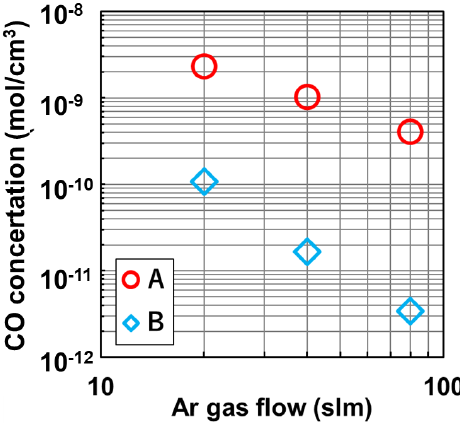
Figure 6. Measured CO concentration as a function of Ar gas flow rate in the furnace Reproduced with permission from Y. Miyamura, H. Harada, X. Liu, S. Nakano, S. Nishizawa, K. Kakimoto, Journal of Crystal Growth; published by Elsevier, 2019 [8].